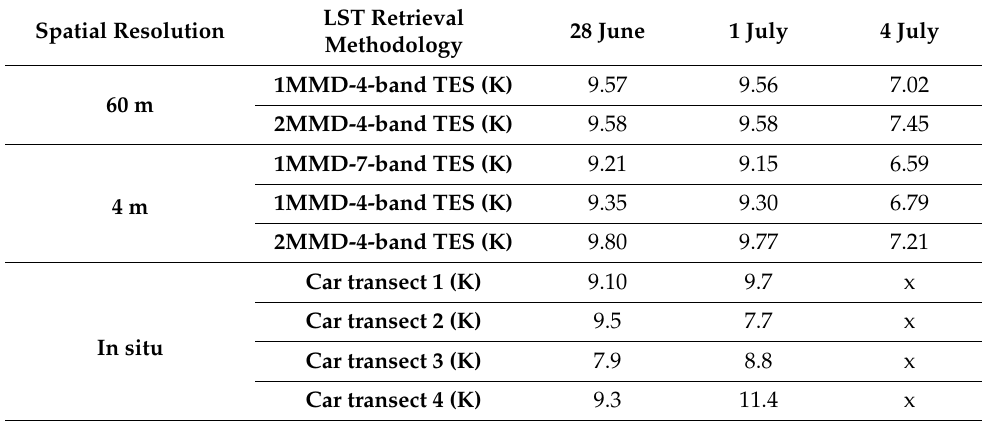
Table 12. Estimated SUHI from 60-m and 4-m LST with the 1MMD-7-band TES, 1MMD-4-band TES and 2MMD-4-band TES, and from ground measurements of LST. Results for the three studied dates are